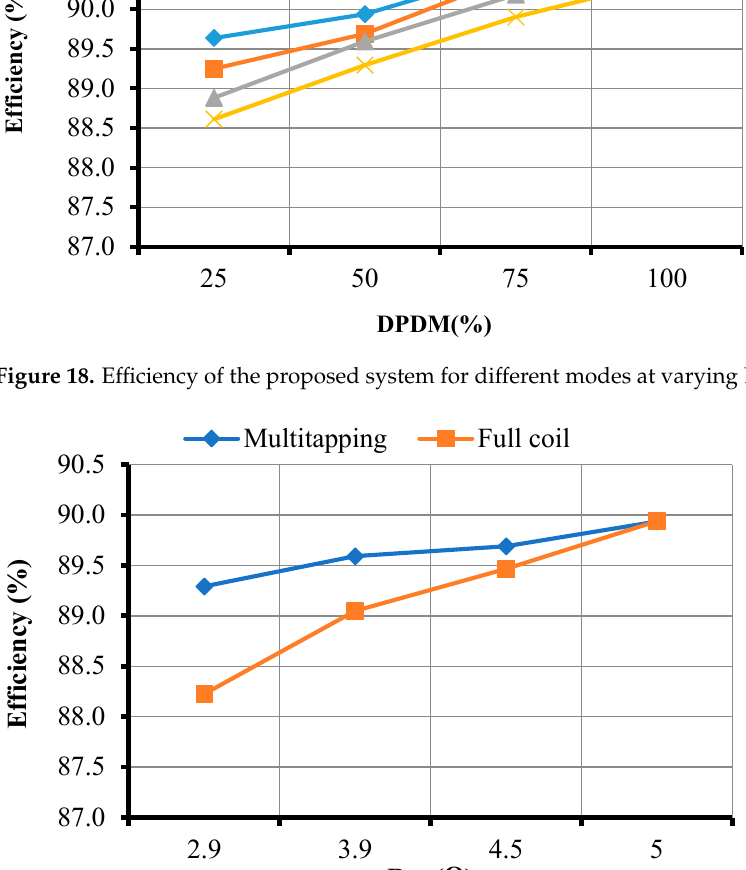
Figure 18. Efficiency of the proposed system for different modes at varying DPDM.